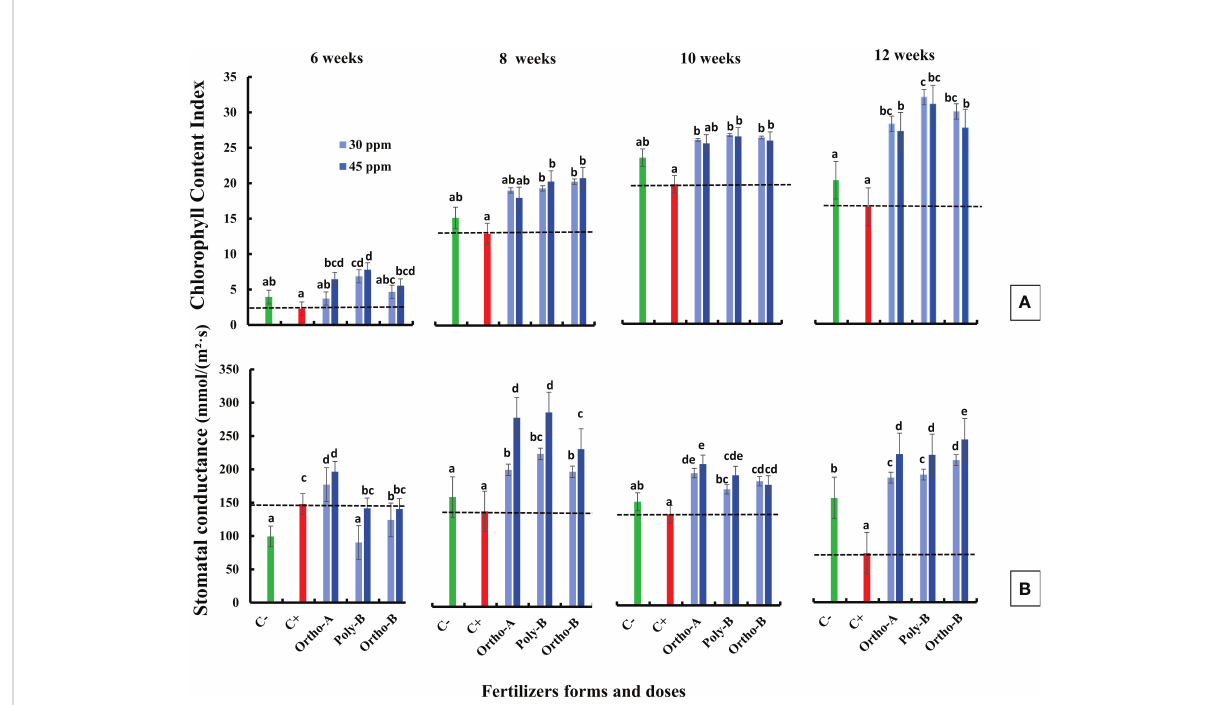
FIGURE 1 The combined effect of P-fertilizer forms (Ortho-A, Poly-B and Ortho-B) and doses (0, 30 and 45 ppm) on Chlorophyll content index (CCI) (A) and Stomatal conductance (SC) (B) of wheat plants grown under salt stress conditions, measured at 6, 8, 10 and 12 WAS. C-: unfertilized plants without salt application, C+ salt-stressed and unfertilized plants. Statistical analysis was performed using one-way ANOVA and SPSS data processing software. GT2 of the Hochberg test was used for the comparison of means. Treatments having the same letters are not signi fi cantly different at the 5%